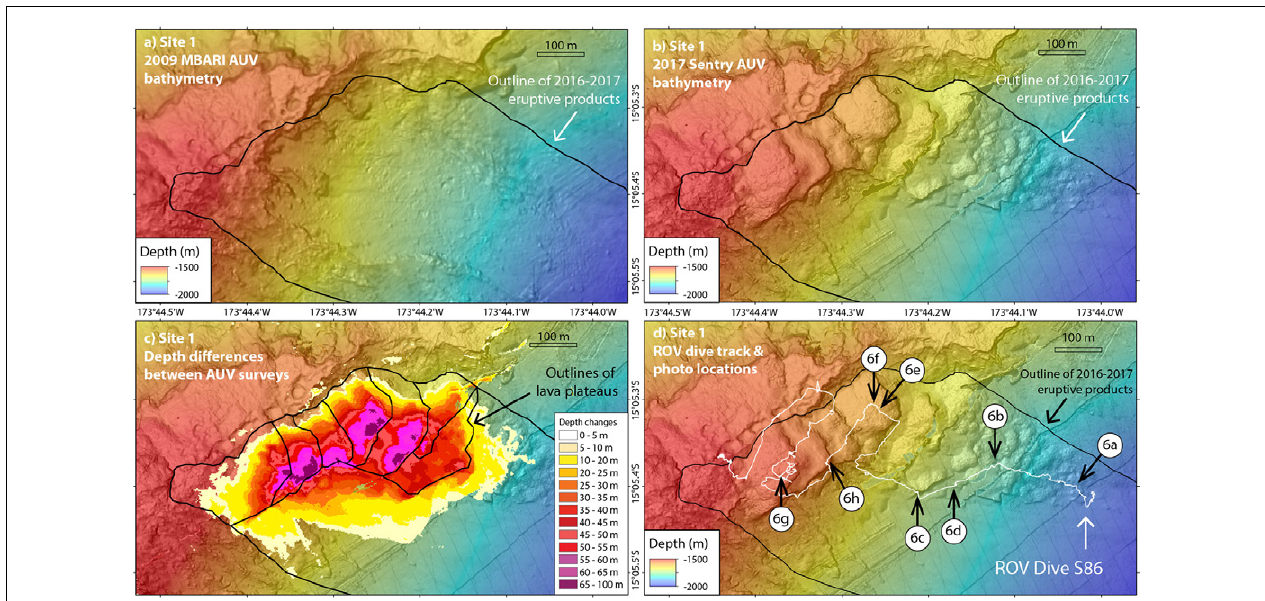
FIGURE 5 | Close-up maps of eruption site #1 showing (a) pre-eruption MBARI AUV bathymetry from 2009, (b) post-eruption Sentry AUV bathymetry from 2017, (c) positive depth differences between the AUV surveys (after the 2017 Sentry AUV grid was co-registered by shifting it 8 m east and 16 m south), and (d) trackline of SuBastian ROV dive S86 (white line) on post-eruption Sentry AUV bathymetry, with locations of images in Figure 6 (white numbered circles). Part of SuBastian ROV dive S103 also crossed this area, but is not shown in (d) . In (c) note that shingled lava plateaus thicken downslope away from the rift zone (see text for discussion). Black outlines enclose the site #1 eruption deposits and mark the edges of individual shingled lava